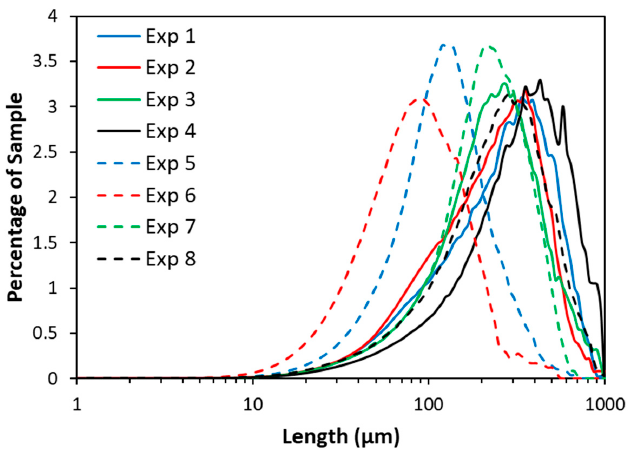
Figure 6. Volume-weighted length distribution for each antisolvent crystallisation experiment.